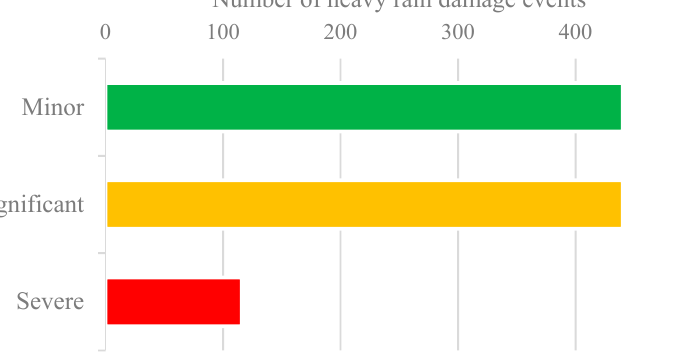
Figure 3. Number of heavy rain damage events by damage category.